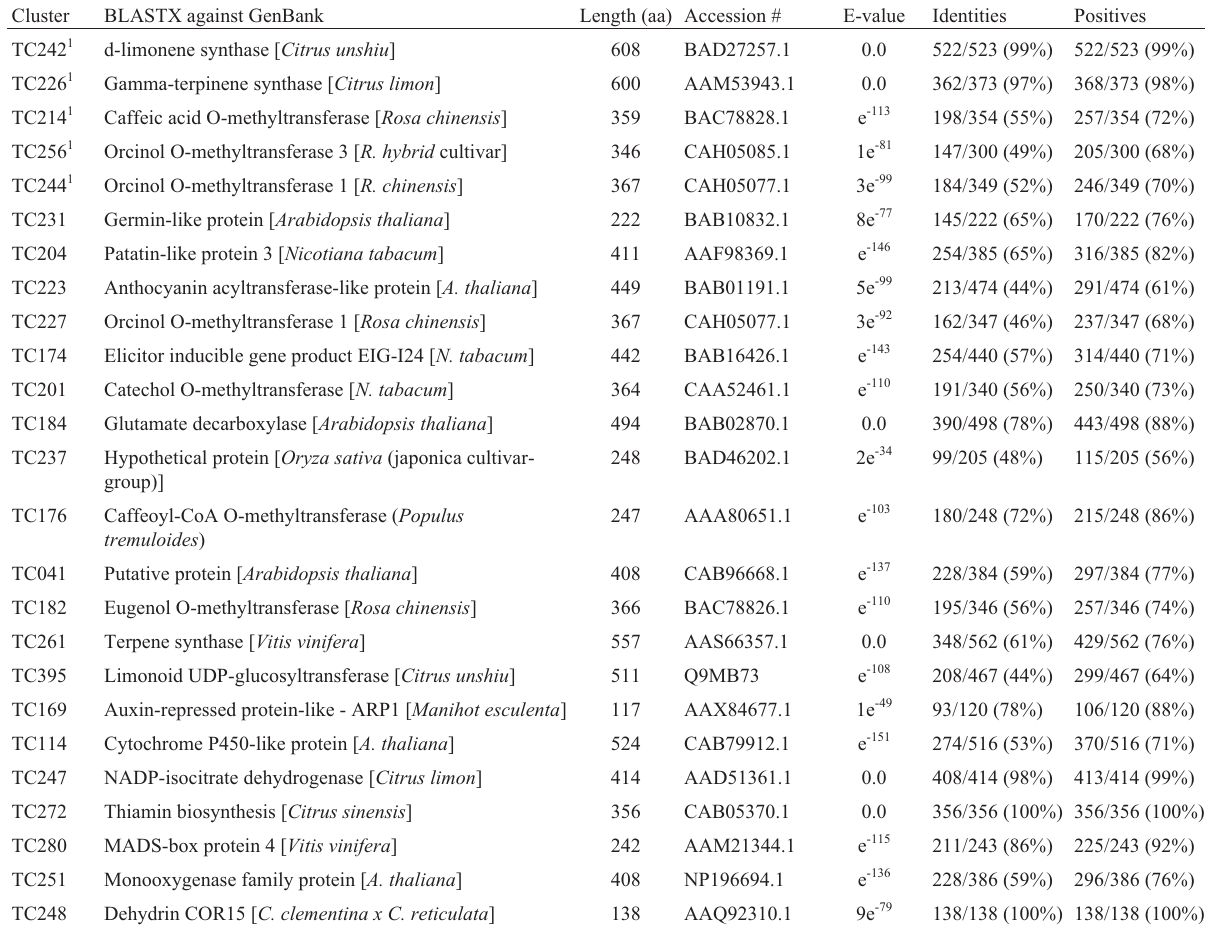
Table 1 - Flavedo differentially expressed sequences, putative flavedo-specific and -enriched genes: BLAST results.